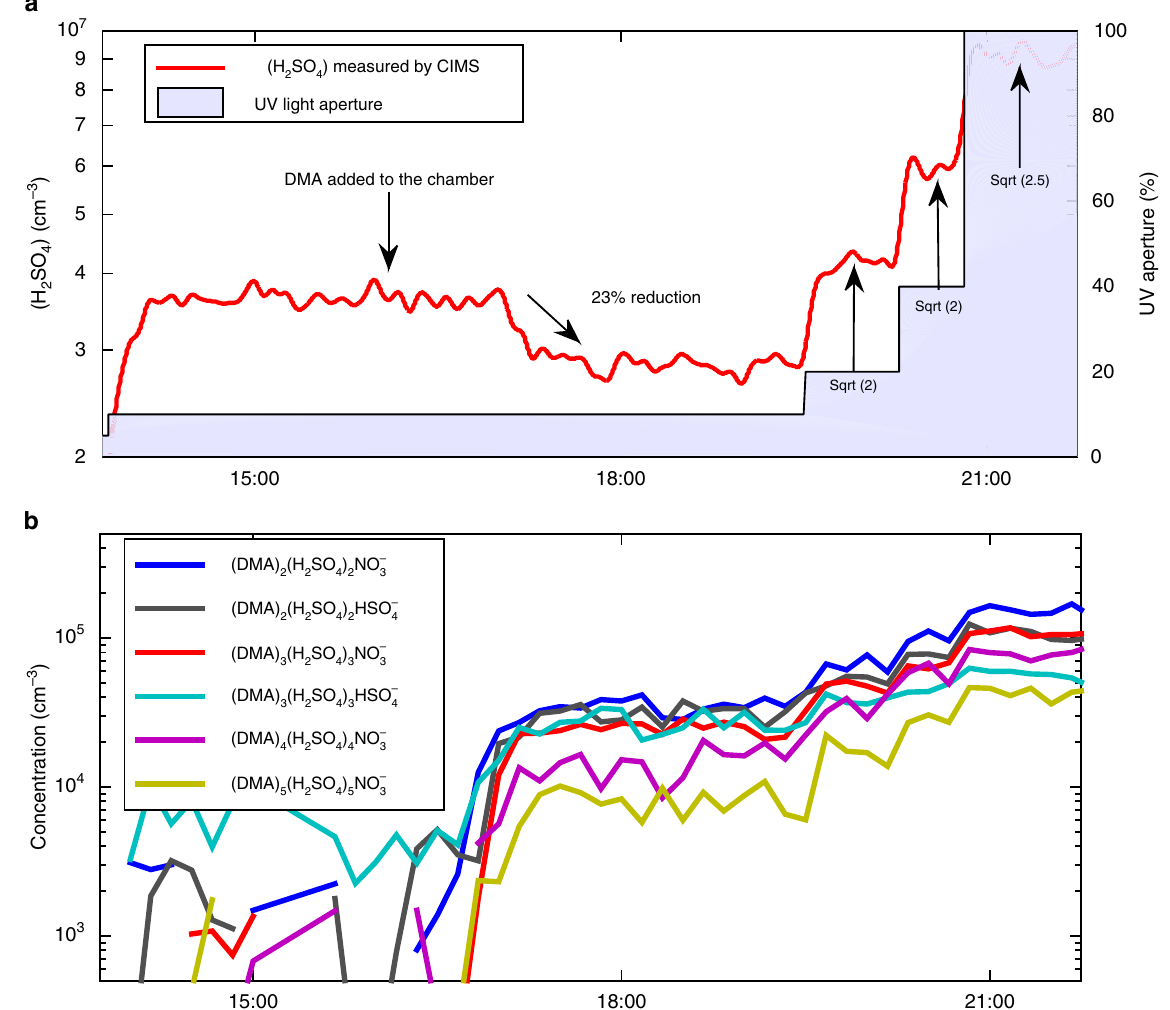
Figure 2 | First addition of DMA. ( a ) Sulphuric acid monomer concentration (red line) measured by the CIMS as a function of time. In the beginning of the experiment (14:00–16:00) no dimethylamine was added to the chamber and the DMA concentration was below detection limit. After addition of DMA (the DMA flow was started around 16:00, after which it took some time to reach the chamber) the measured H 2 SO 4 monomer concentration decreased, although the production rate of H 2 SO 4 remained constant. After 19:30 the ultra violet light intensity (blue shaded area) was stepwise increased to increase production of sulphuric acid. ( b ) Concentrations of selected DMA–H 2 SO 4 clusters measured with the CI-APi-TOF for the same time